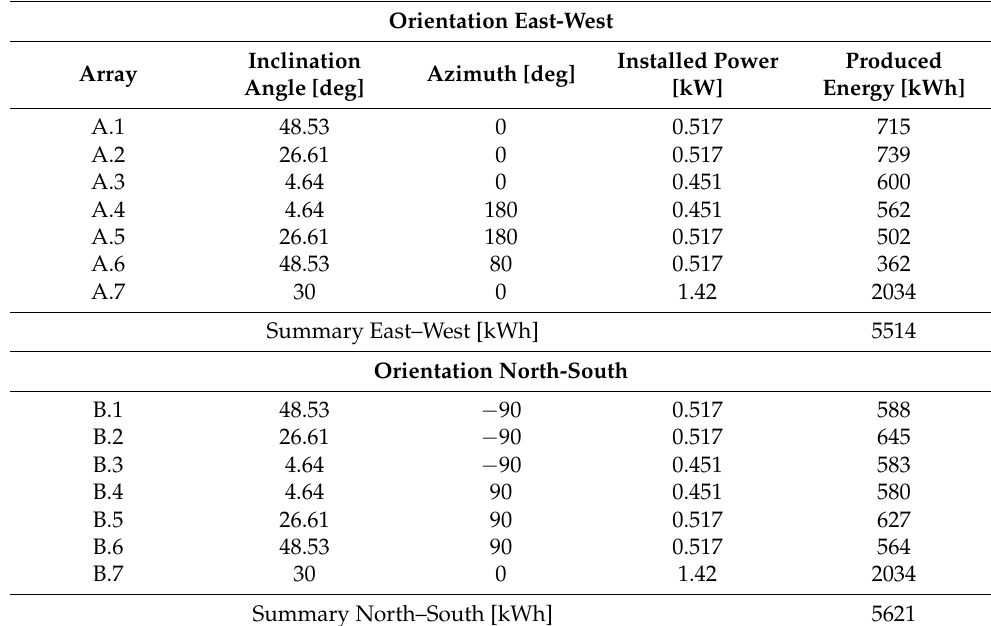
Table 7. PV’s array inclination and azimuth